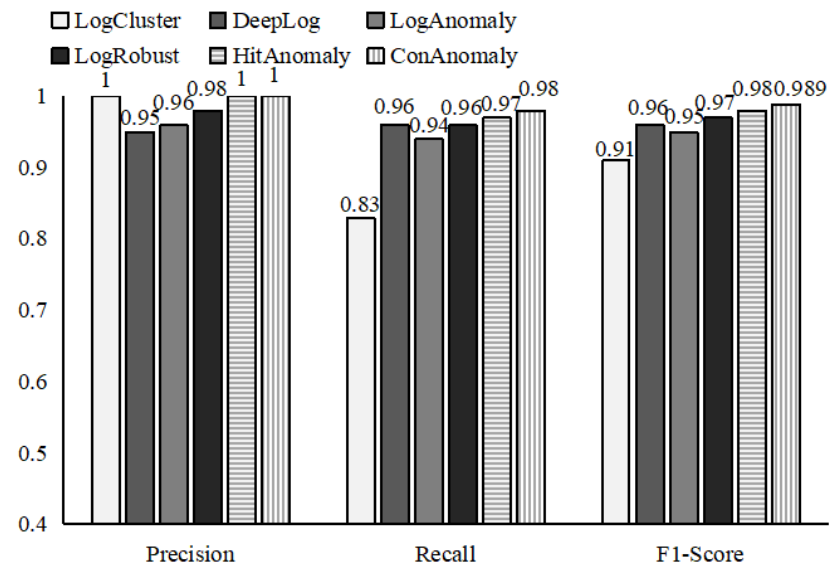
Figure 6. Evaluation on HDFS dataset.